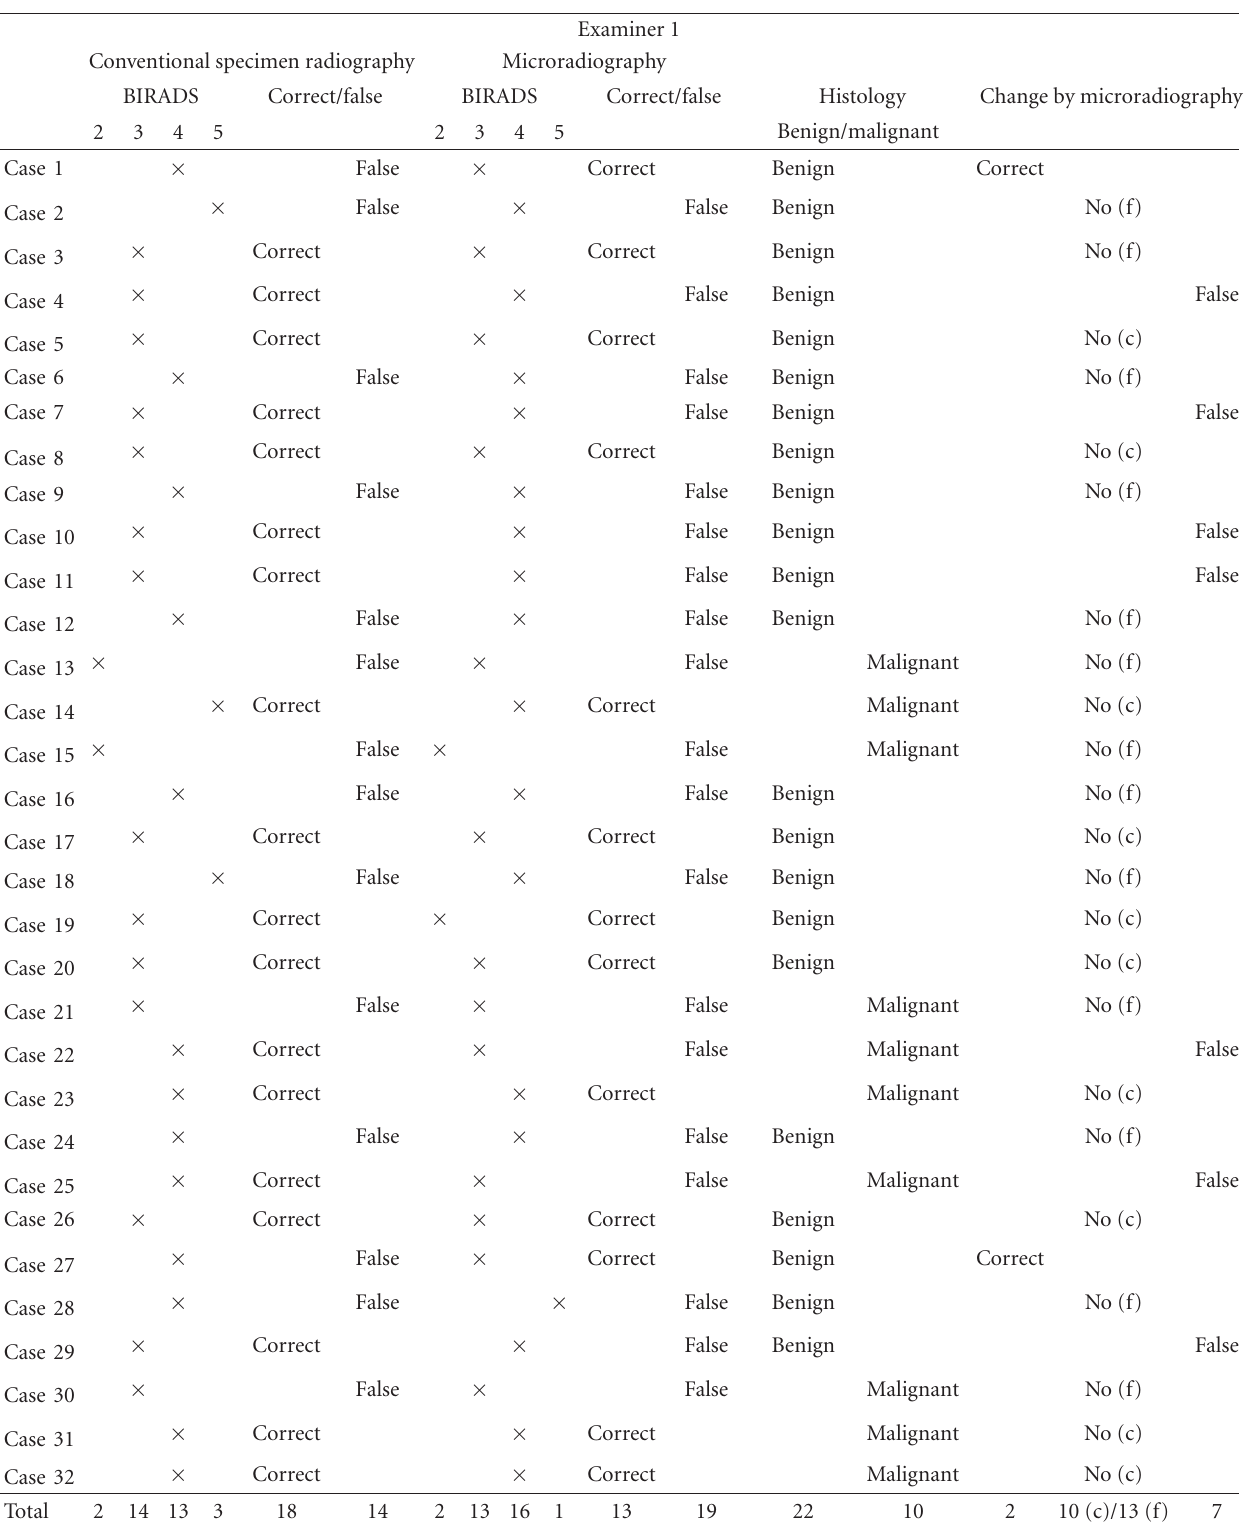
Table 1: BIRADS classification in conventional radiography and microradiography. Changes by microradiography were only rated if diagnosis changed from the benign group (BIRADS 2 and 3) in to the malignant group (BIRADS 4 and 5) and backwards, respectively. No change correct is “No (c)” and no change false is “No